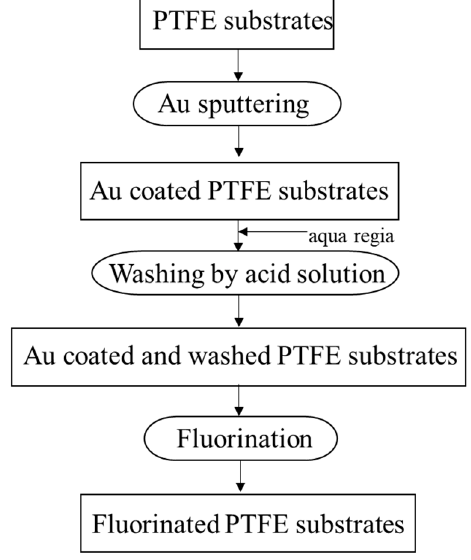
Figure 1. Flow diagram for preparation of fluorinated PTFE. Table 1. Sample names and reaction conditions.